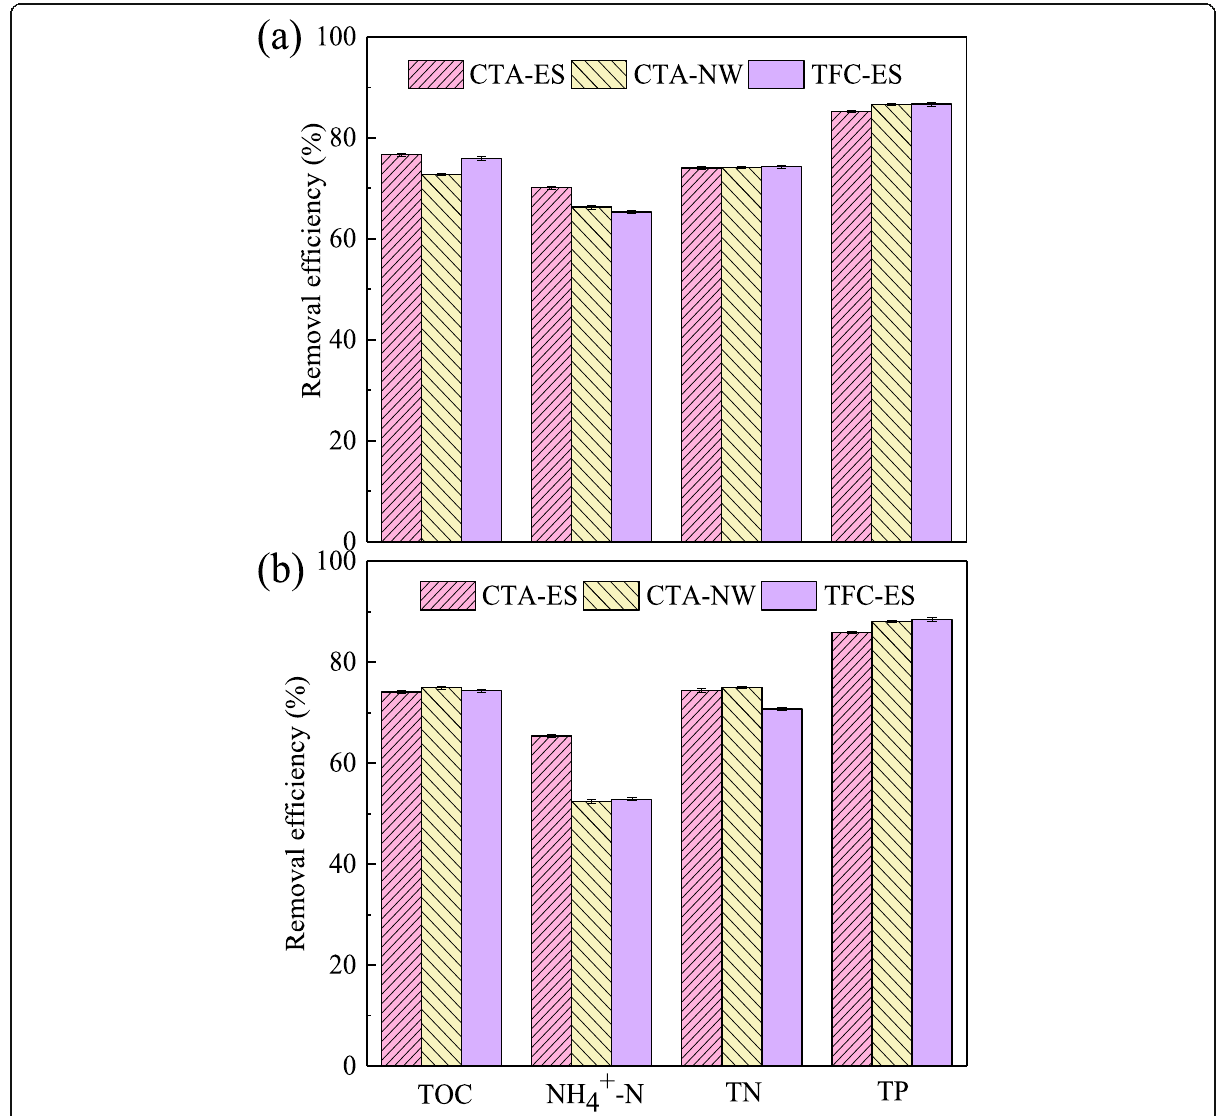
Fig. 4 The removal efficiencies after treatment for OsMFC with different FO membrane in AL-FS mode ( a ), AL-DS mode ( b